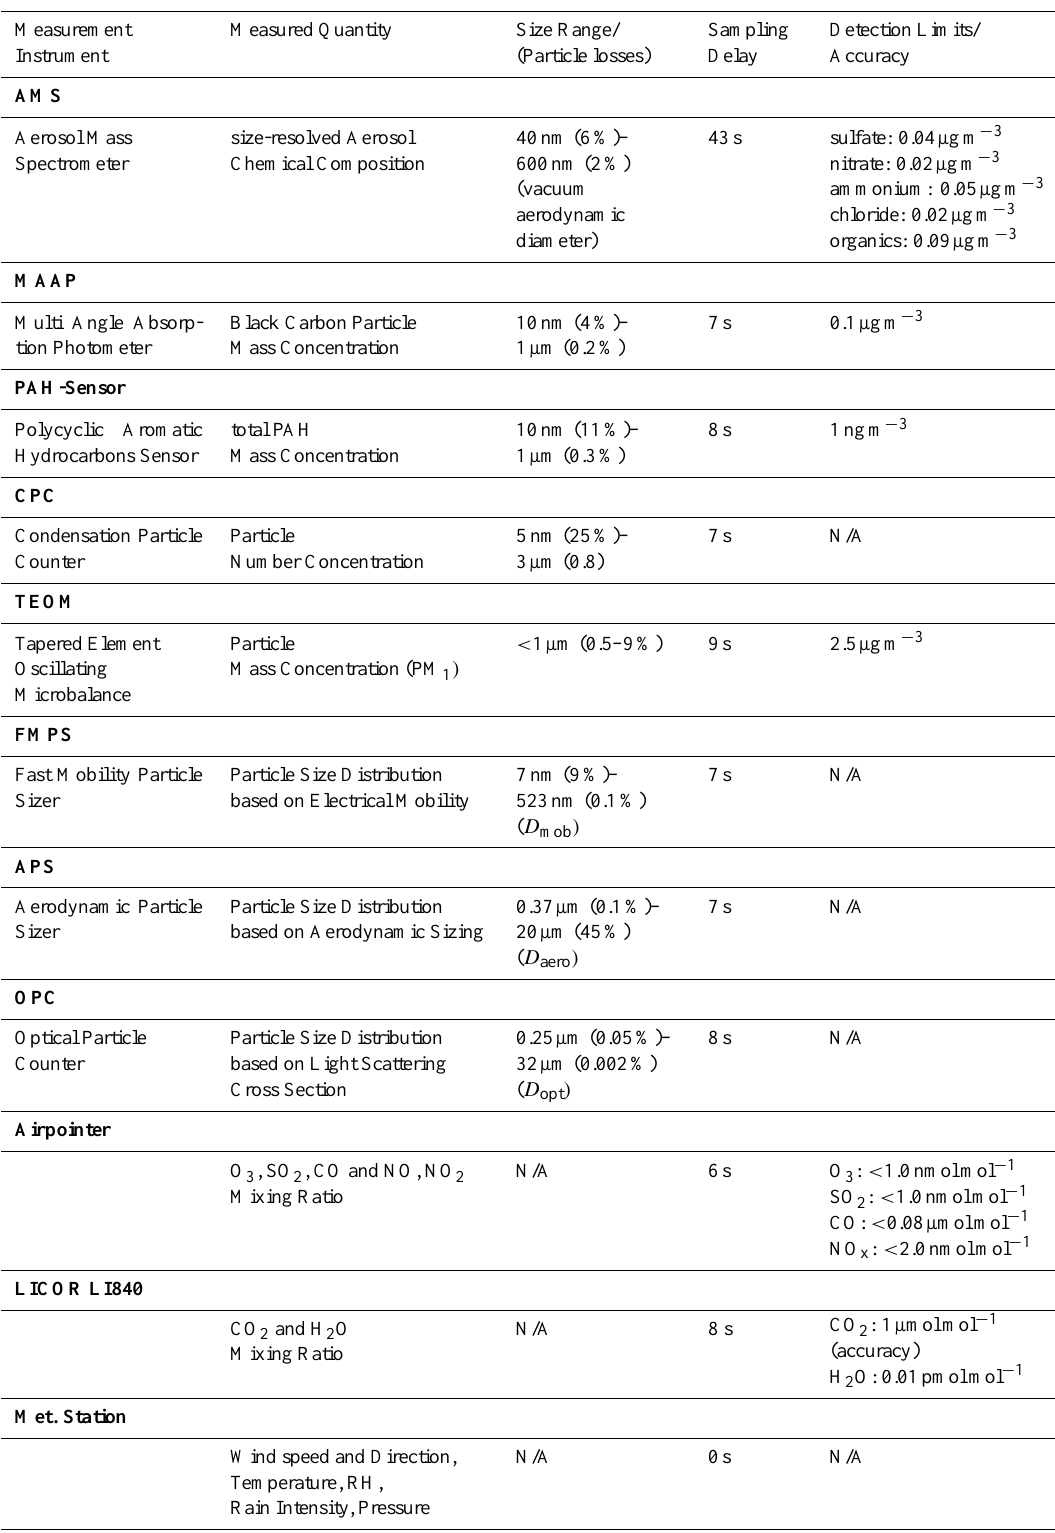
Table 1. Summary of measured quantities, size ranges and the corresponding particle losses, sampling time delays and detection limits for the instruments implemented in the mobile laboratory (MoLa). Particle losses within the given size range boundaries are lower than those provided here; therefore the given losses are upper